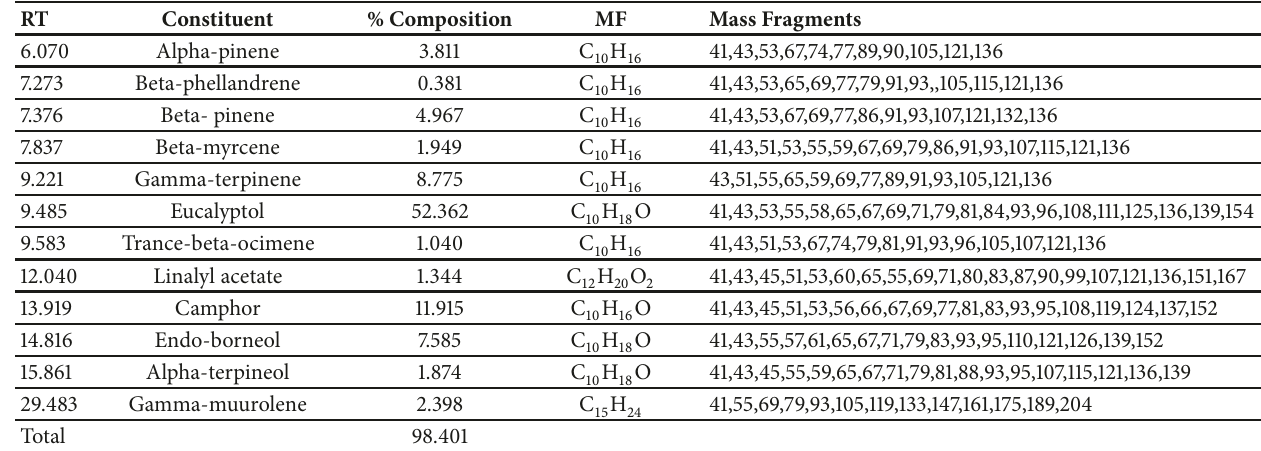
Figure 2: Photo of rabbit skin before (a) and one hr after removing the test ointment (b). Table 1: L. angustifolia leaves oil chemical composition.